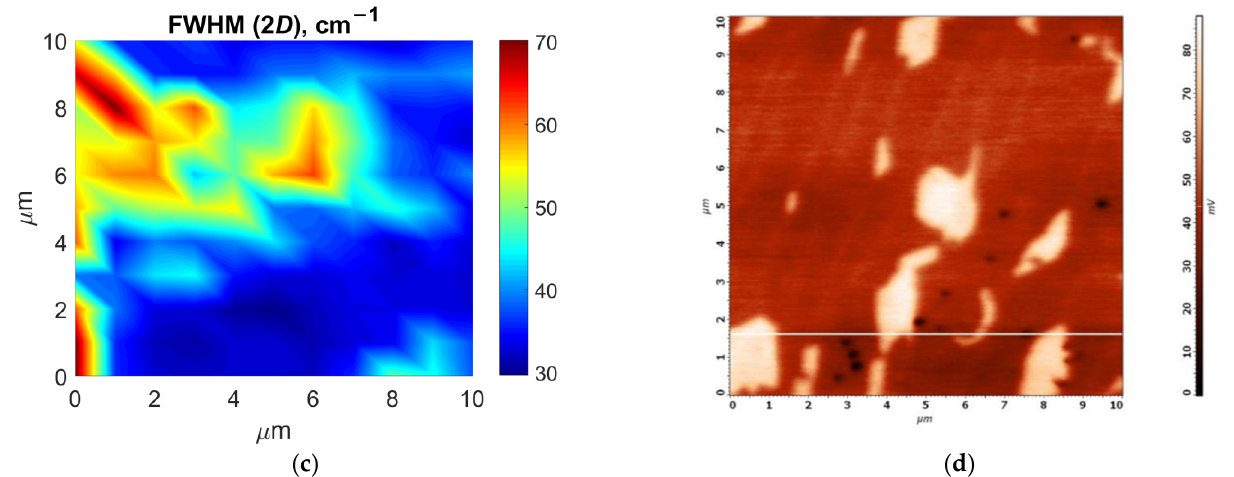
Figure 2. Raman spectra of Group 1 and 2 chips before and after functionalization. ( a ) Typical Raman spectra of monolayer graphene areas in the chip before (blue line) and after (green line) functionalization. The spectra are presented after subtraction of the 4H-SiC substrate spectrum contribution. ( b ) Typical Raman maps of 2D line FWHM (full width at half-maximum) distribution for the chips from Group 1 with ~5% of bilayer inclusions. ( c ) Typical Raman maps of 2D line FWHM distribution for the chips of Group 2 with ~30% of bilayer inclusions. ( d ) A typical surface potential map of a chip from Group 2, which reveals the presence of bilayer inclusions as light spots of different sizes.